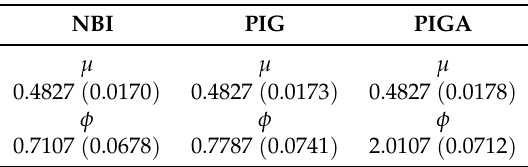
Table 2. Negative Binomial Type I (NBI), Poisson-Inverse Gaussian (PIG), and Poisson-Inverse Gamma (PIGA) distributions.